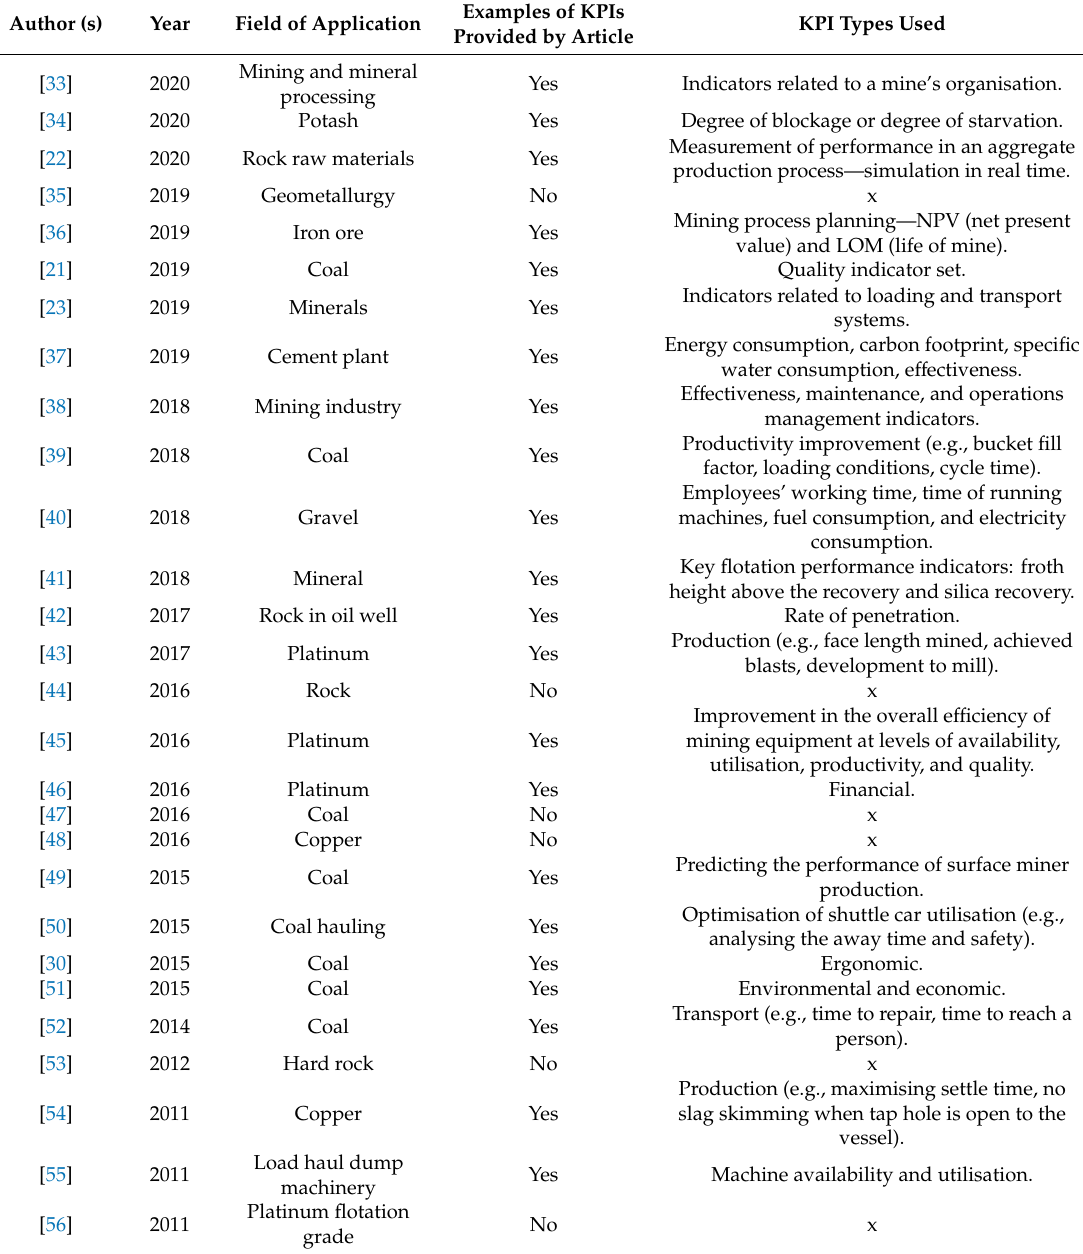
Table 1. Types of indicators in the selected publications.